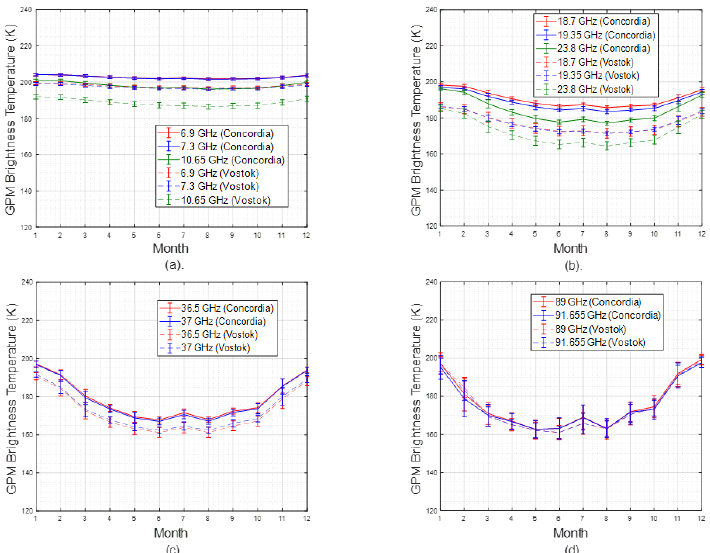
Figure 10. Vertically polarized brightness temperatures measured by AMSR2 and SSMIS over (solid) Concordia and (dashed) Vostok Stations in Antarctica versus month between 2020 and 2021 at frequencies ( a ) 6.9 GHz, 7.3 GHz, and 10.65 GHz; ( b ) 18.7 GHz, 19.35 GHz, and 23.8 GHz; ( c ) 36.5 GHz and 37 GHz; and ( d ) 89 GHz and 91.65 GHz. The vertical lines demonstrate the ranges of ± 1 monthly standard deviations. Note that all measurements except those from the 6.9 GHz and 7.3 GHz channels of AMSR2 are intercalibrated and the brightness temperatures were averaged over month and 0.25° × 0.25° grids.